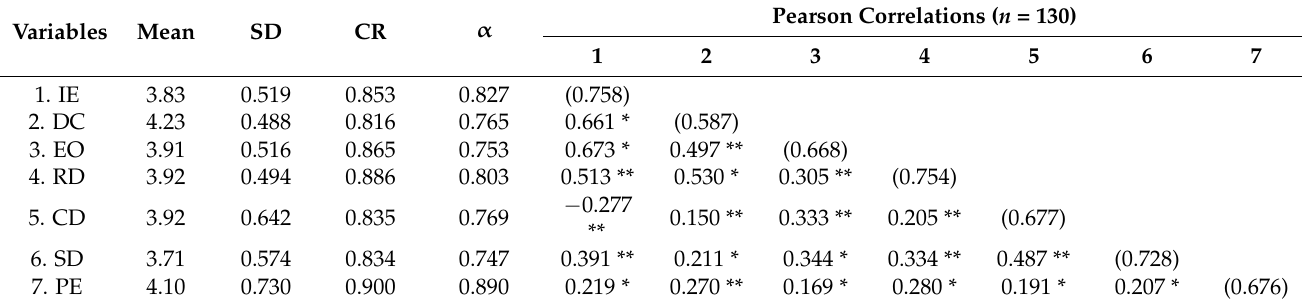
Table 2. Descriptive statistic, CR, Alpha, AVE and correlation analysis for